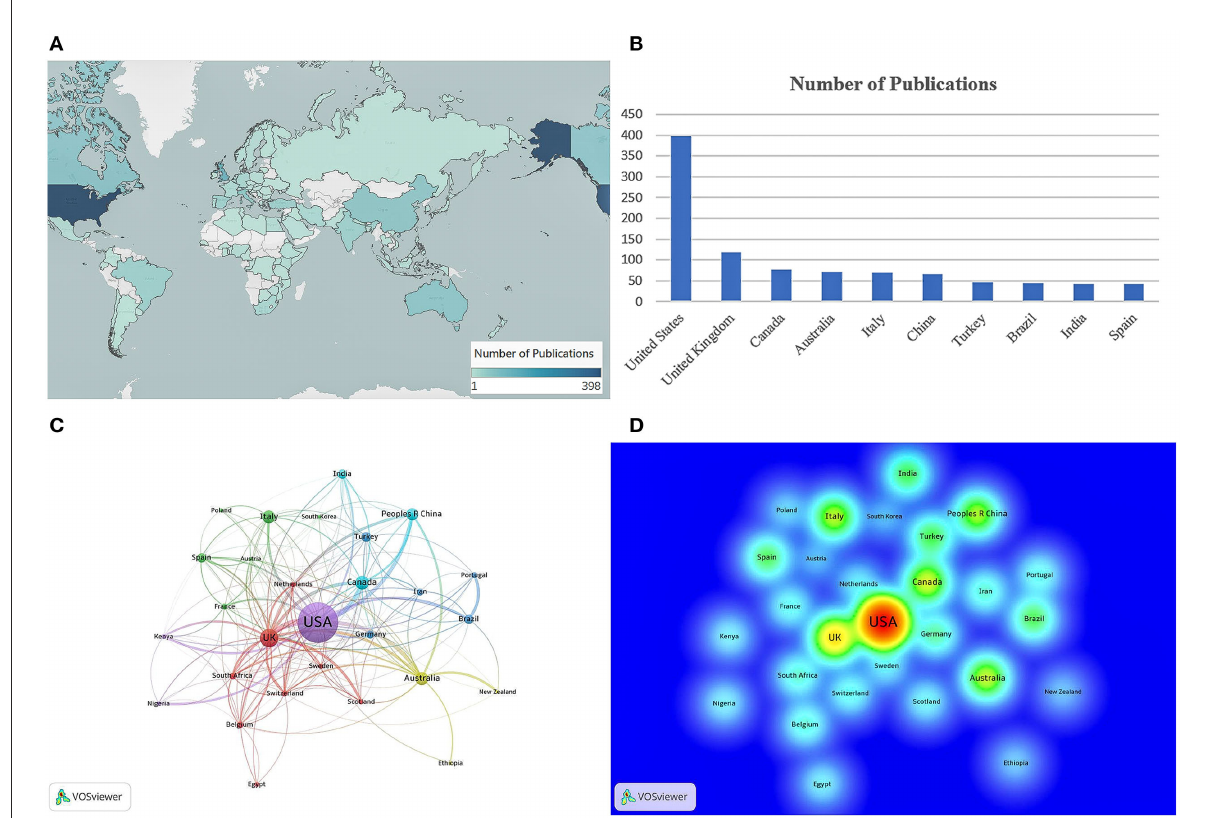
FIGURE2 Contributions of different countries and regions to publications. (A) Geographic map of research countries and regions. (B) Histogram of top 10 countries in terms of the number of documents. (C) Cooperation network visualization between countries and regions. (D) Density map of countries and